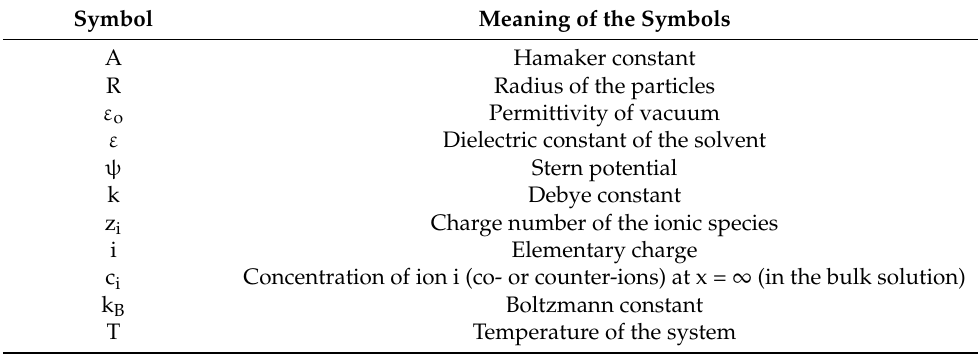
Table 1. Symbols of the DLVO theory.